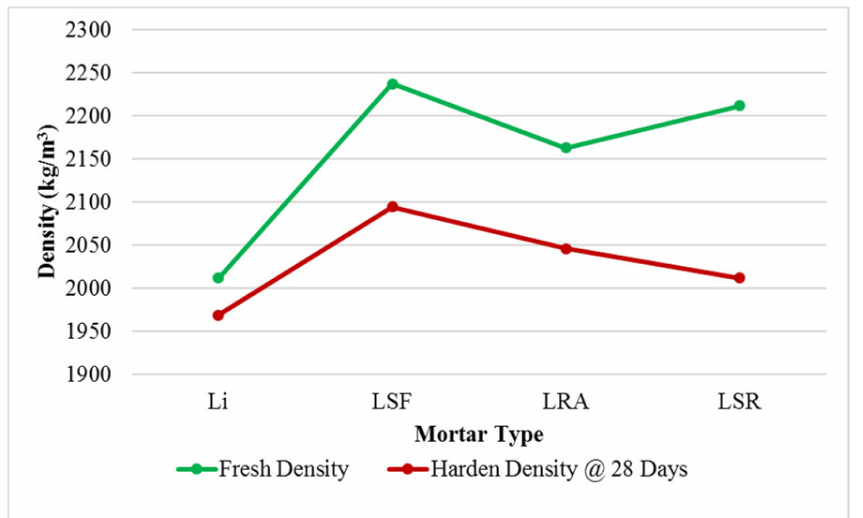
Figure 8. Density of lime and lime composite mortars.